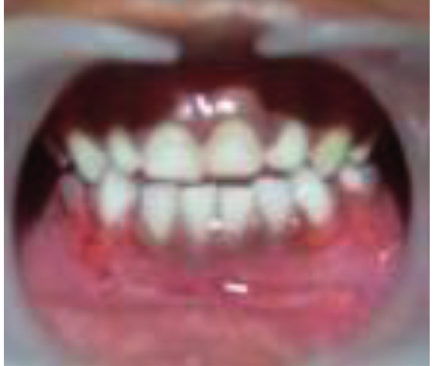
Figure 5: Intraoperative reduction of the segments.